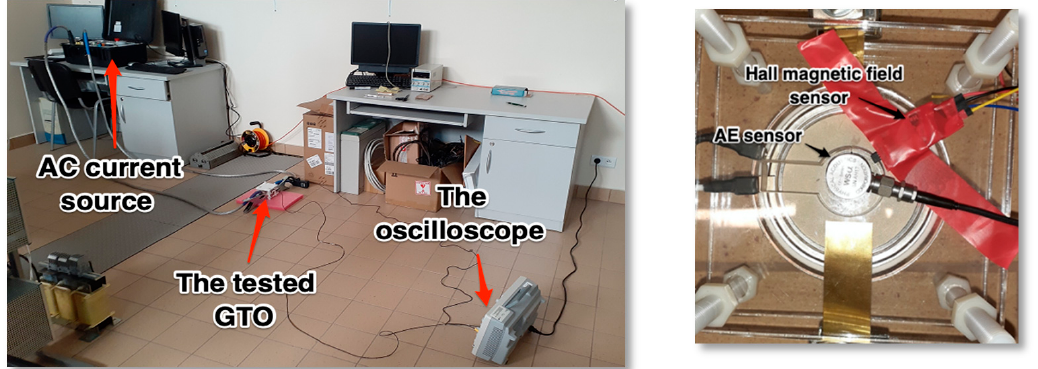
Figure 8. The laboratory test stand arrangement ( left ) and GTO 5SGS16H2500 symmetrical thyristor with AE and Hall effect sensors placed upon without a top pressing plate ( right ).